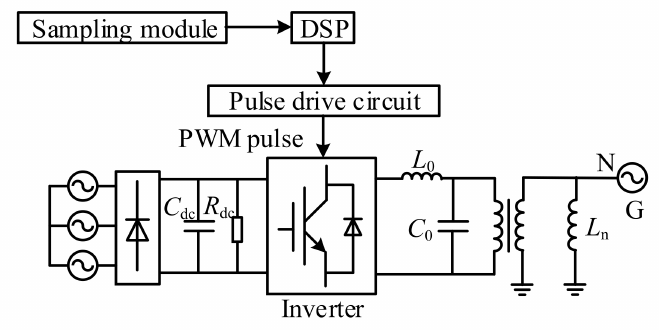
Figure 3. Topological diagram of the active arc-suppression